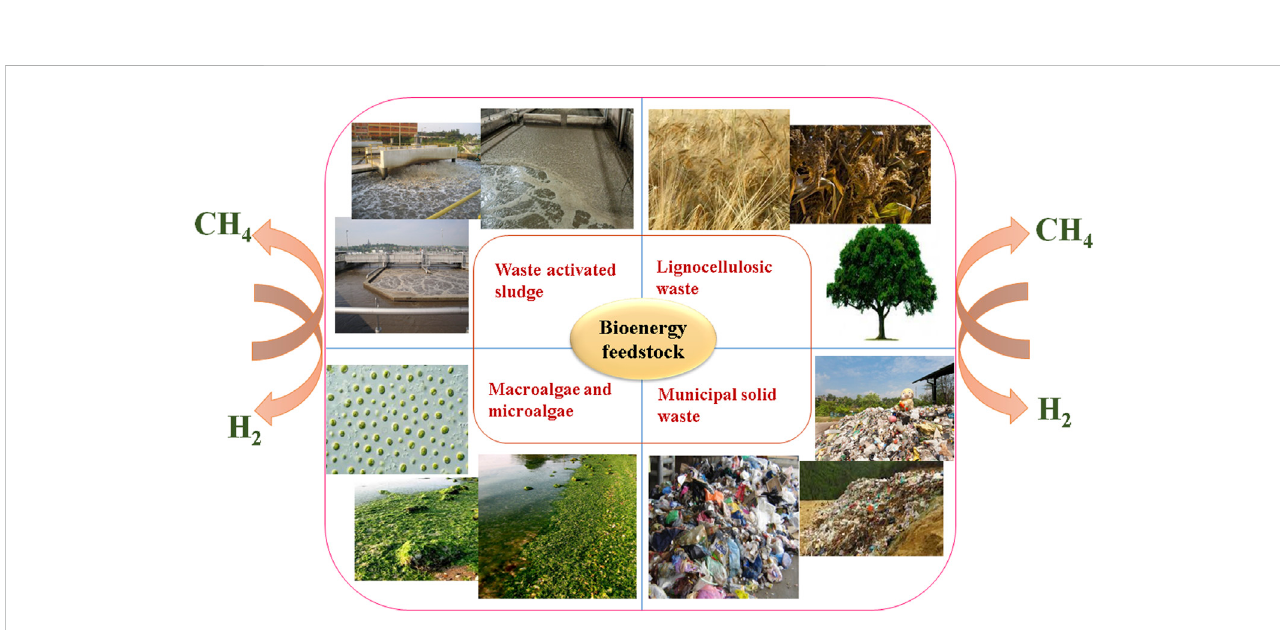
FIGURE 2 Various feedstock for sustainable energy